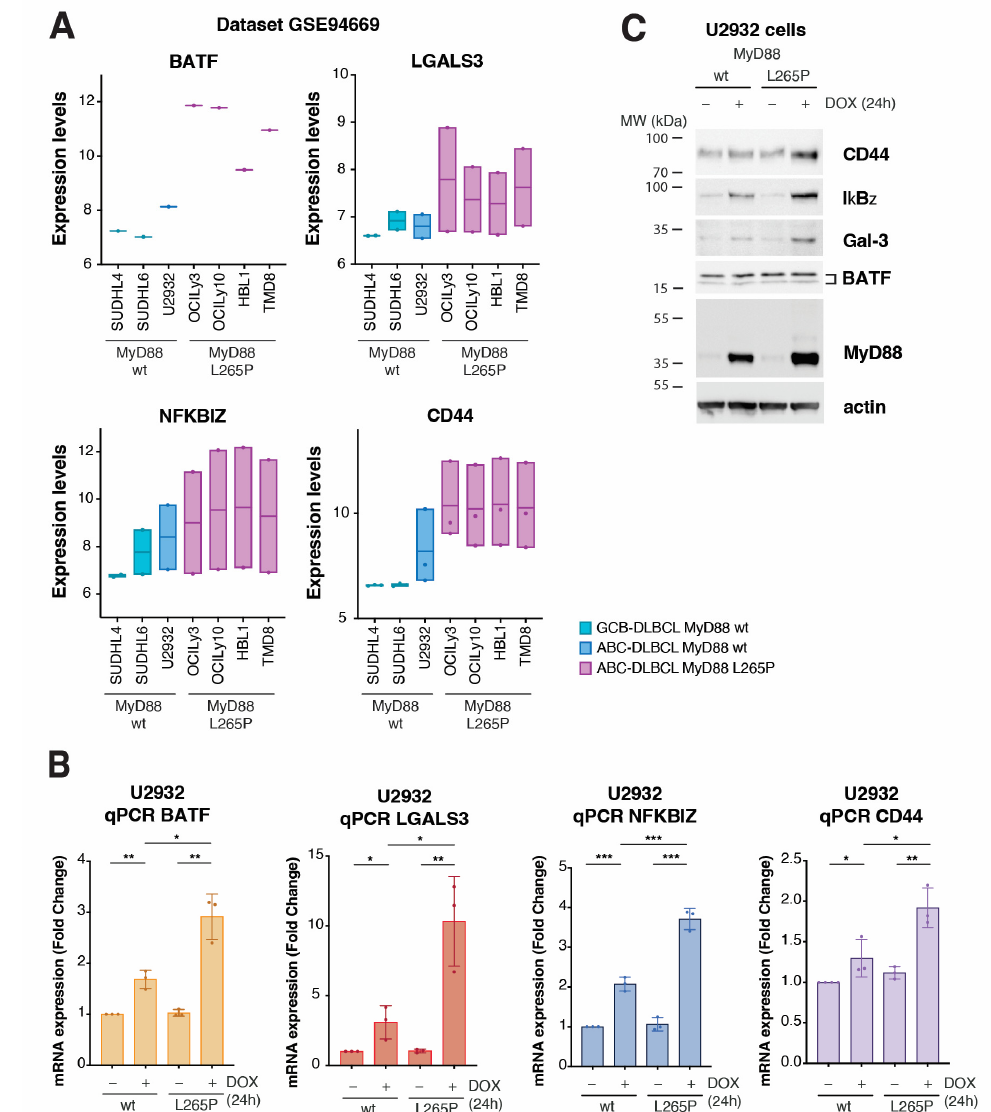
Figure 3. Validation of transcriptomic results using publicly available datasets and in the model cell lines. ( A ) Gene expression validation in the immortalized cell lines, using microarray expression dataset GSE94669 for genes BATF , LGALS3 , NFKBIZ, and CD44 . In the dataset containing the gene expression of 61 cell lines, 7 representative cell lines were considered. Cell lines SUDHL4 and SUDHL6 represent GCB DLBCL with wt MyD88. U2932 represents ABC DLBCL with wt MyD88. OCI ‐ Ly3, OCI ‐ Ly10, HBL1, and TMD8 represent ABC DLBCL with MyD88 L265P . The y ‐ axis represents the normalized expression according to microarray data. ( B ) qPCR validation of differentially expressed genes BATF , LGALS3 , NFKBIZ, and CD44 in the U2932 cell line upon MyD88 (wt/L265P) inducible expression after 24 h of DOX treatment (* for p ≤ 0.05, ** for p ≤ 0.01, *** for p ≤ 0.001). ( C ) Western blot validation of the 4 hits (BATF, Gal ‐ 3, IkB ƺ , and CD44) upon MyD88 (wt/L265P) inducible expression after 24 h of DOX treatment (250 ng/mL) in the U2932 cell line. Actin was used as a loading control.